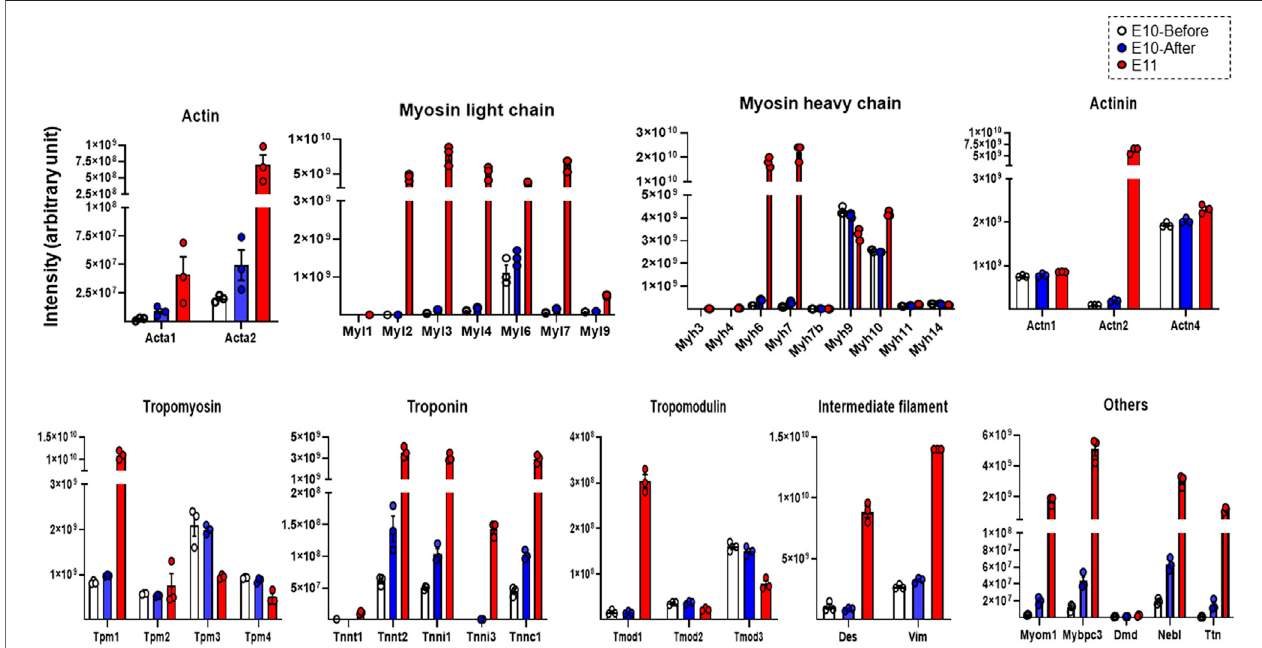
FIGURE 3 | Expression levels of representative constituent proteins of myo fi brils and sarcomeres assessed by DIA-MS in the heart primordium before and after heartbeat initiation and in the primitive heart tube. The expression levels of each protein obtained by DIA-MS proteome analysis for which both a peptide false discovery rate (FDR) < 1% and a protein FDR < 1% are satis fi ed are represented for actin, myosin light chain, myosin heavy chain, actinin, tropomyosin, troponin, tropomodulin, intermediate fi lament and other components of myo fi laments and sarcomeres. Values are expressed as intensity normalized by the median of all protein quantitation in each sample. Individual protein expression levels were simply represented as dot plots, means, and SEM in order to avoid multiple testing and data extraction errors inthis small sample number (N =3 each). Acta1, Actin, alpha skeletal muscle; Acta2, Actin, aortic smoothmuscle;Myl1, Myosin lightchain 1/3,skeletal muscle isoform; Myl2, Myosin regulatory light chain 2; ventricular/cardiac muscle isoform; Myl3, Myosin light chain 3; Myl4, Myosin light chain 4; Myl6, Myosin light polypeptide 6; Myl7, Myosin light chain 7; Myl9, Myosin regulatory light polypeptide 9; Myh3, Myosin-3; Myh4, Myosin-4; Myh6, Myosin-6; Myh7, Myosin-7; Myh7b, Myosinheavychain7B;Myh9,Myosin-9;Myh10,Myosin-10;Myh11,Myosin-11;Myh14,Myosinheavychain14;Actn1,Alpha-actinin-1;Actn2,Alpha-actinin-2;Actn4, Alpha-actinin-4; Tpm1, Tropomyosin alpha-1 chain; Tpm2, Tropomyosin beta chain; Tpm3, Tropomyosin alpha-3 chain; Tpm4, Tropomyosin alpha-4 chain; Tnnt1, TroponinT,slowskeletalmuscle;Tnnt2,TroponinT,cardiacmuscle;Tnni1,TroponinI,slowskeletalmuscle;Tnni3,TroponinI,cardiacmuscle;Tnnc1,Cardiactroponin C;Tmod1,Tropomodulin-1;Tmod2, Tropomodulin-2;Tmod3,Tropomodulin-3; Des,Desmin; Vim,Vimentin;Myom1,Myomesin 1;Mybpc3, Myosin-bindingproteinC, cardiac-type; Dmd, Dystrophin; Neb, Nebulette; Ttn, Cardiac titin fetal N2BA PEVK